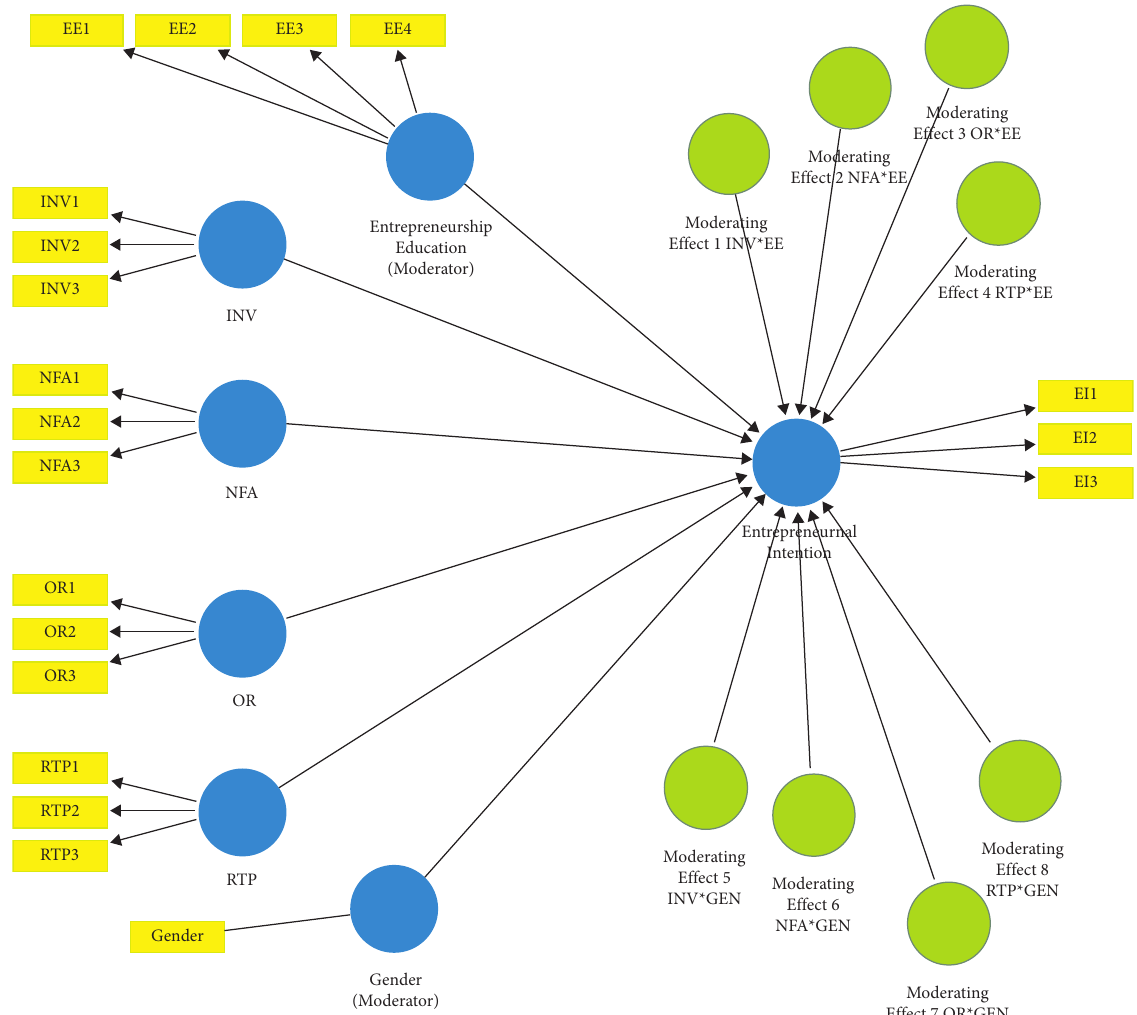
Figure 5: Graphical presentation of the model under study, also showing moderation effect of EE and GEN. Source: Extracted from SmartPLS Software after analysis of